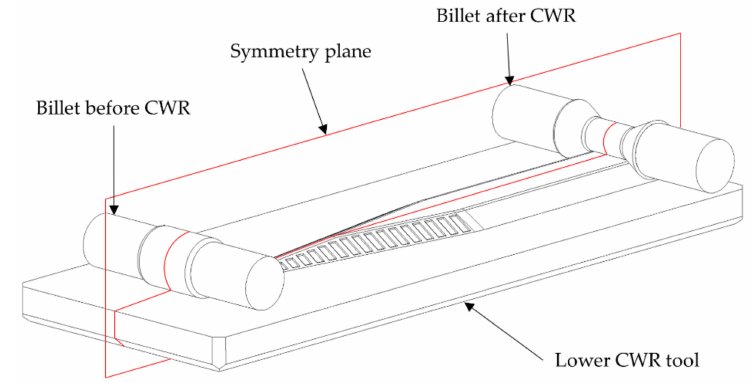
Figure 4. Model of the cross-wedge rolling process.